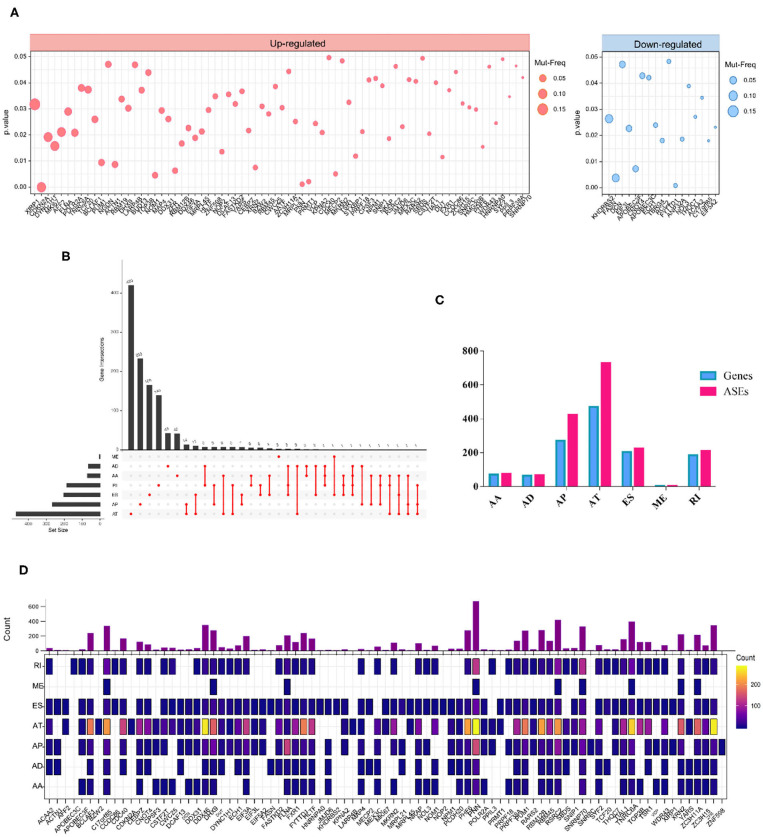
RBP mutations induced mRNA expression alterations. (A) A total of 91 RBPs exhibit significant different mRNA expression levels induced by mutations (Wilcoxon test P-values < 0.05). The left and right panels indicate the up- and downregulation of the mRNA expression level of tested RBPs. The circle size corresponds to the mutation frequency of SKCM samples. (B) Upset plot showed splicing alterations induced by mRNA expression-associated RBP mutations. The black bar on the left represents the counts of different splicing patterns, while the red dots and lines on the right indicate the intersections of ASEs. (C) Bar graph represents the number of each splicing type as well as corresponding spliced genes. (D) Distribution of splicing events per RBP with mRNA expression-affecting mutations. The color intensity indicates the occurrence counts of each type of ASEs.